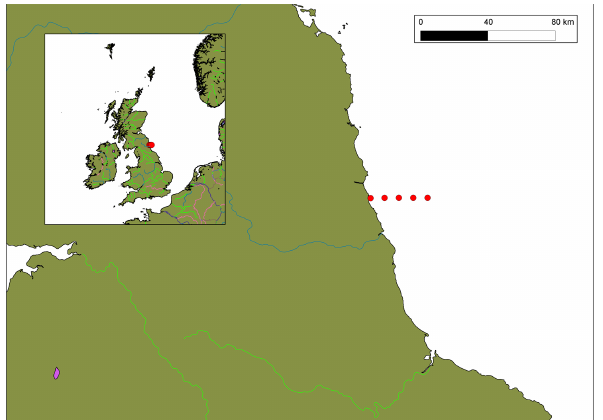
Figure 6. The sampling stations (red circles) on the transects in the coastal North Sea off northeast